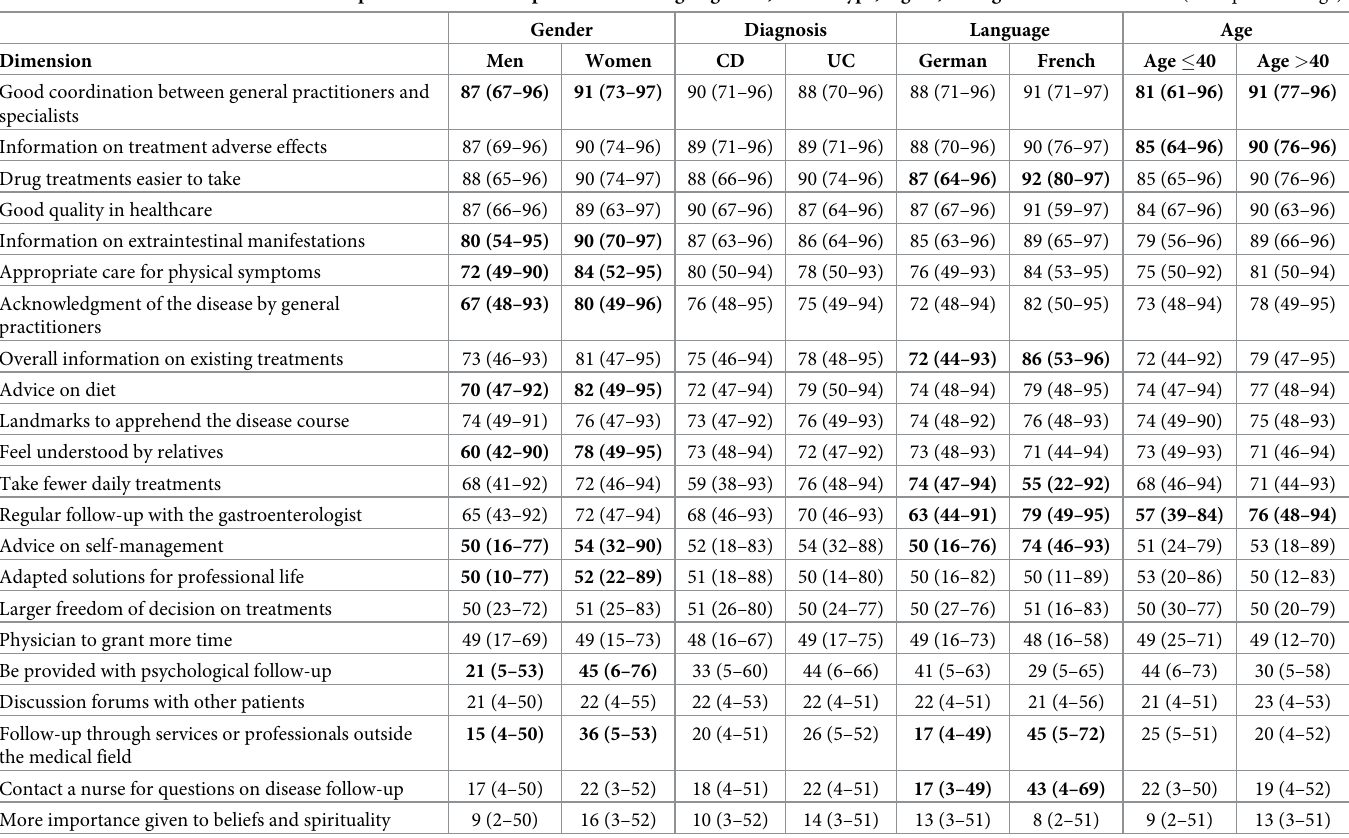
Table 4. Scores for individual healthcare expectations of SIBDC patients according to gender, disease type, region, and age. Values are medians (interquartile